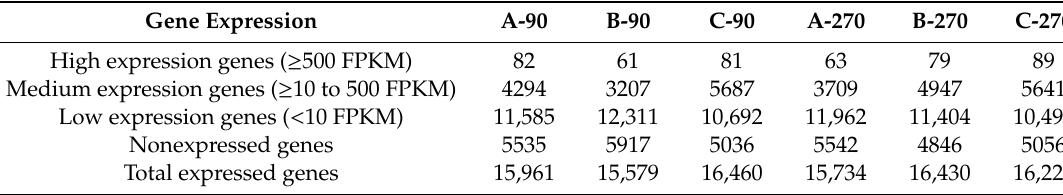
Table 5. Statistics of gene expression in samples.